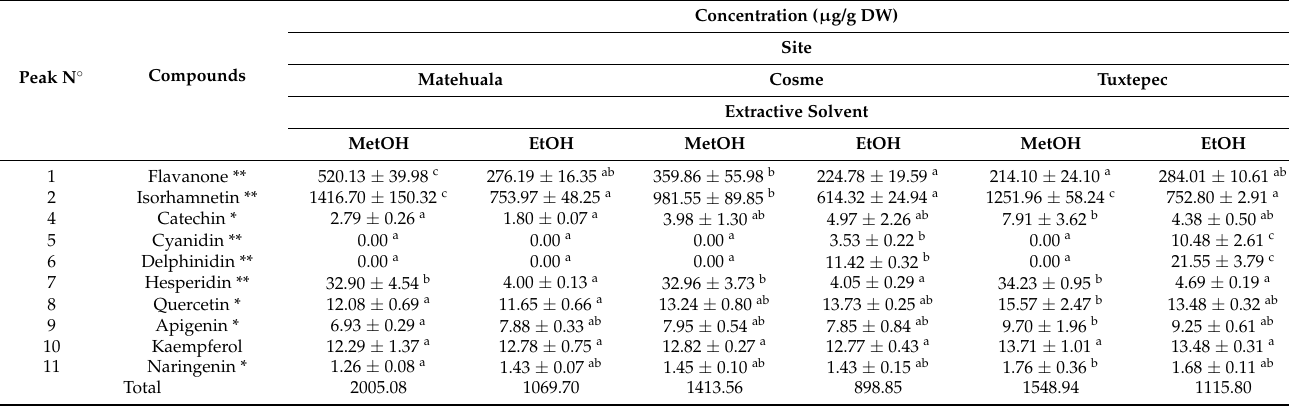
Table 1. Flavonoid concentration ( µ g/g DW) measured by quantitative HPLC-UV using analytical standards (compounds) in ethanolic (EtOH) and methanolic (MetOH) extracts of Agave lechuguilla by-product from three different sampled sites (Matehuala, Tuxtepec and